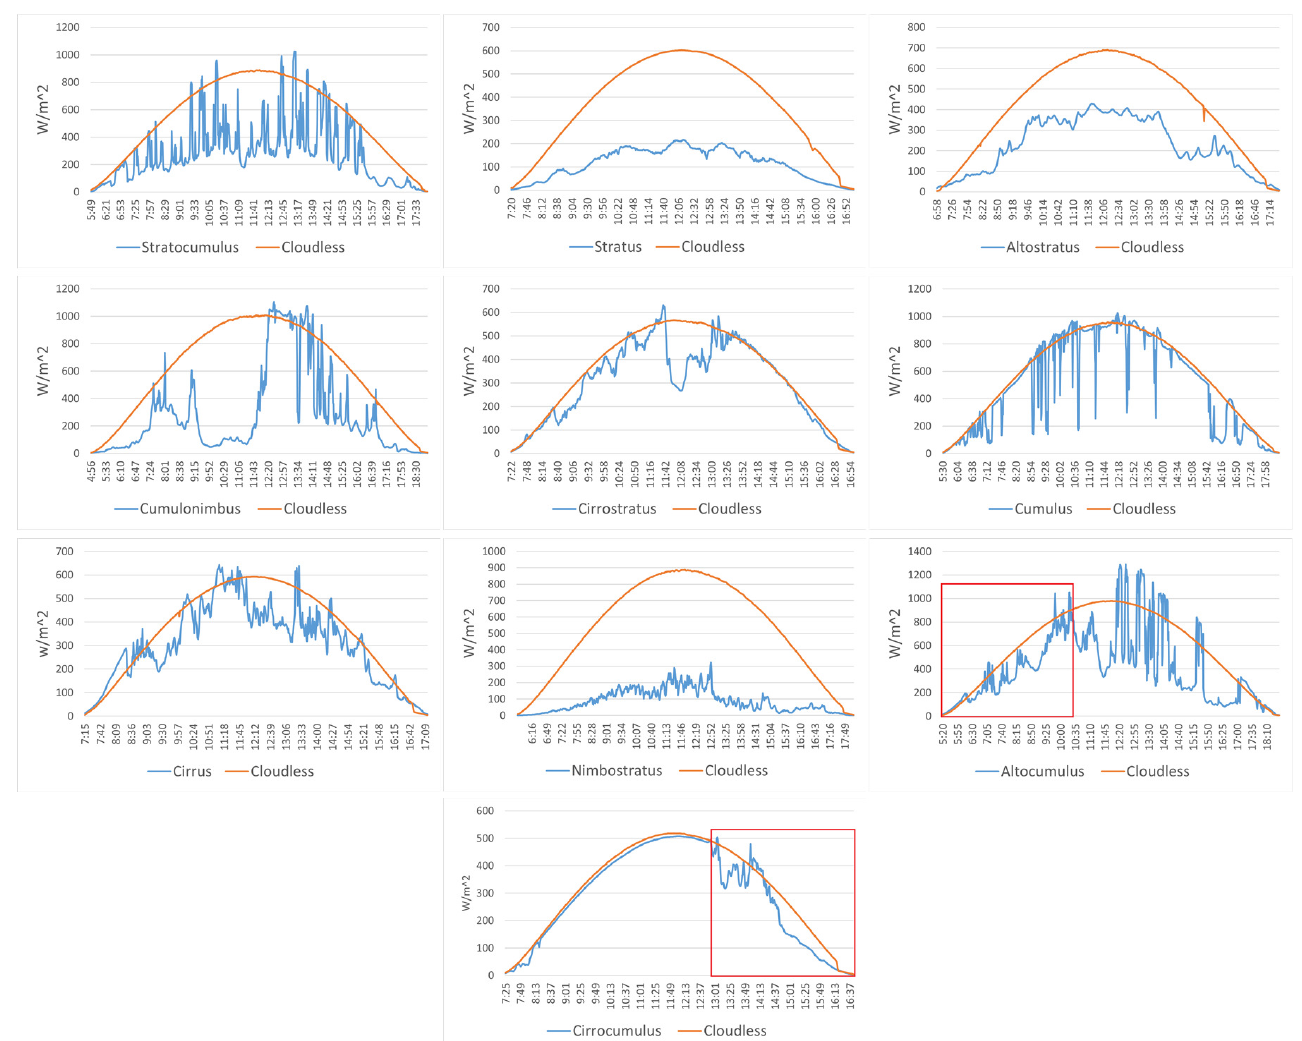
Figure 7. Effect of different cloud genera on solar radiation attenuation. Altocumulus and Cirrocu- mulus are infrequent, we have boxed the time of occurrence in